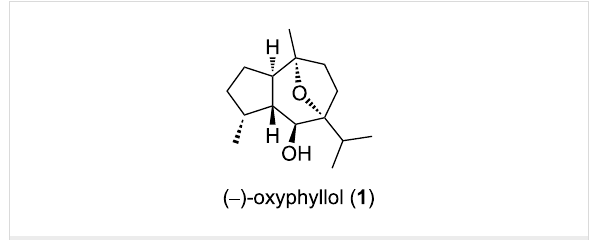
Figure 1: Structure of the guaiane ( − )-oxyphyllol ( 1